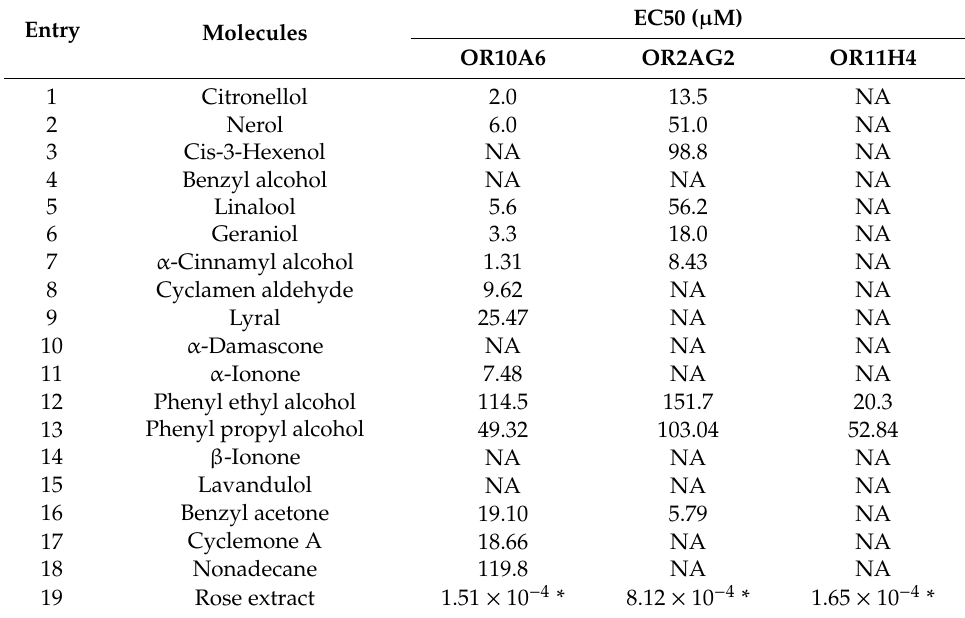
Table 2. EC50 values ( µ M) of various natural odorant activators of OR10A6, OR2AG2, and OR11H4.